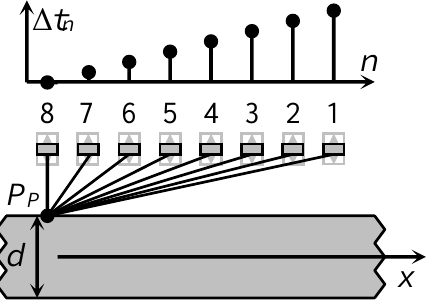
Figure 13. Total acoustic pressure signal at the point P P as a superposition of partial signals radiated by all 8 array elements. The upper time diagram illustrates the time delays Δ t n of the excitation signals.